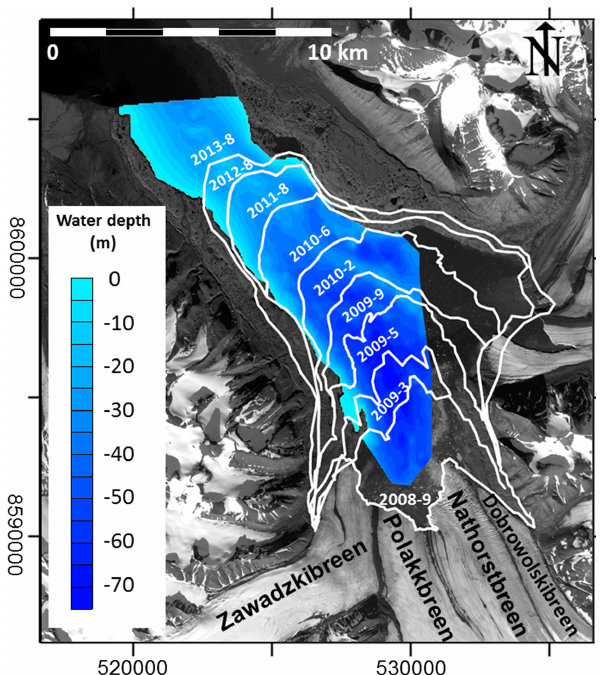
Fig. 7. Front positions (year and month) of Nathorstbreen glacier system during the advancing stage (3) of the surge. Advance by 2013 is 15km. Bed topography modified from Carlsen (2004). The minimum depth is 11m, while the maximum depth is 76m. Back- ground image from 1 September 2008 by SPOT SPIRIT © .